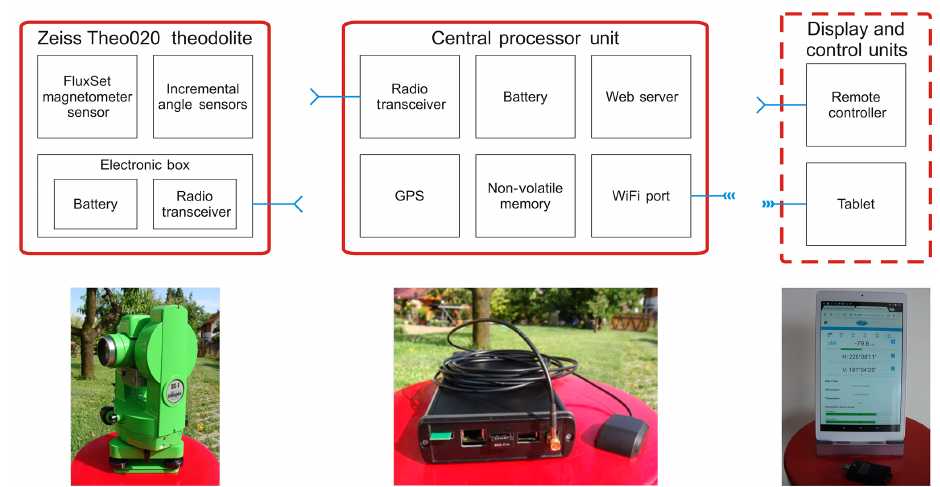
Figure 1. Declination/inclination Digital Station 1